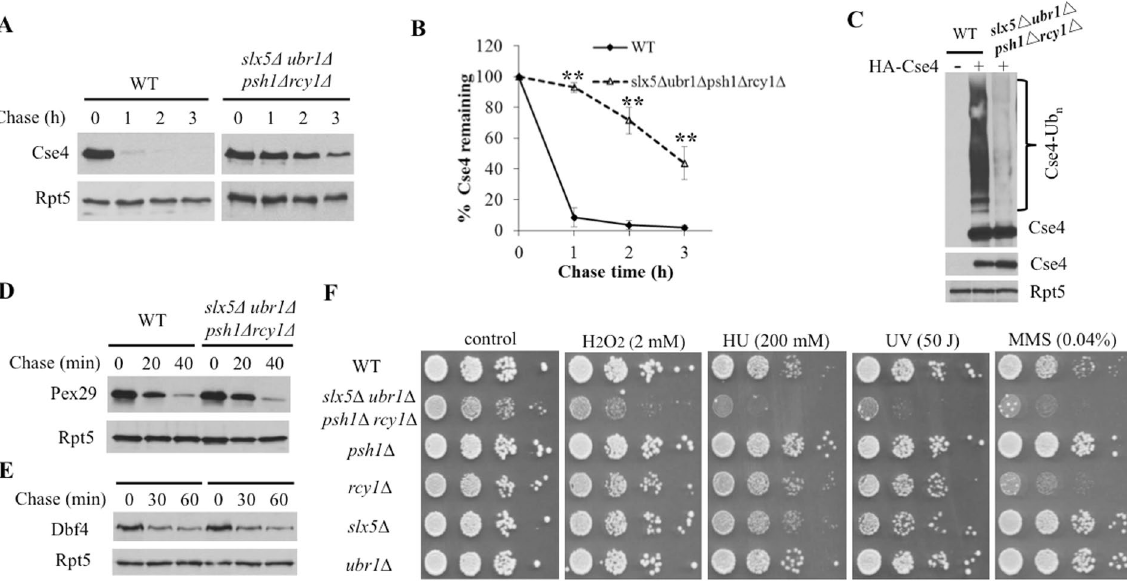
Figure 7. Impaired Cse4 degradation and ubiquitylation in the psh1 Δ rcy1 Δ slx5 Δ ubr1 Δ quadruple mutant cells. ( A , B ) Cse4 degradation in wild-type and psh1 Δ rcy1 Δ slx5 Δ ubr1 Δ cells was determined and quantified as above. ( C ) Cse4 ubiquitylation was determined as described in Fig. 3C. ( D , E ) Degradation of Pex29 and Dbf4 in wild-type and psh1 Δ rcy1 Δ slx5 Δ ubr1 Δ cells. Pex29 and Dbf4 are regulated by the E3s Doa10 and APC, respectively 31 . The degradation kinetics of GST-tagged Pex29 and MORF-tagged Dbf4 were determined as previously described 31 . ( F ) Phenotypes associated with the quadruple mutant psh1 Δ rcy1 Δ slx5 Δ ubr1 Δ . Mutants display stress-sensitive phenotypes. Yeast wild-type cells and mutants lacking one or four E3s were spotted in 10-fold serial dilution onto YPD plates with the indicated agents and concentrations.